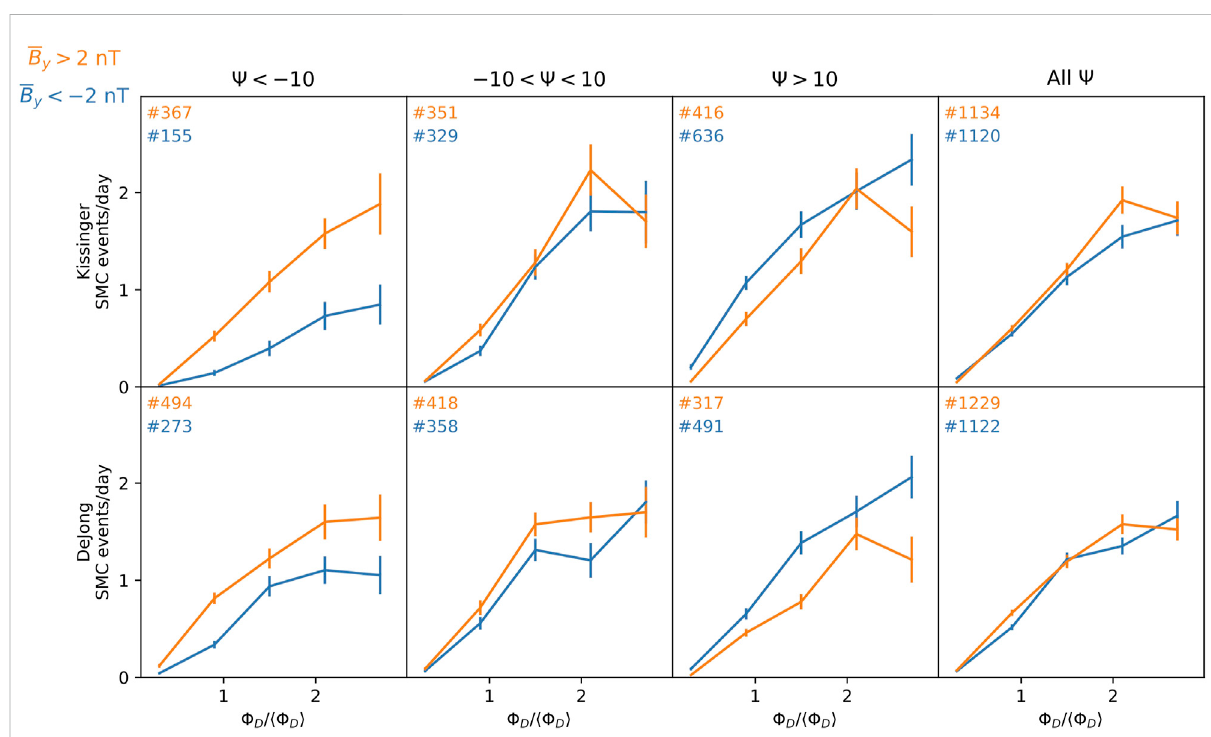
FIGURE 1 Average occurrence rates of SMC intervals (number per day on y-axis) versus increasing levels of dayside reconnection rate. Top row: SMC list describedbyKissingeretal.(2012).Bottomrow:SMClistdescribedbyDejong(2014).AnexplicitB y dependenceintheSMCoccurenceratesareseen in both lists: Opposite B y /tilt polarity also lead to more frequent SMC